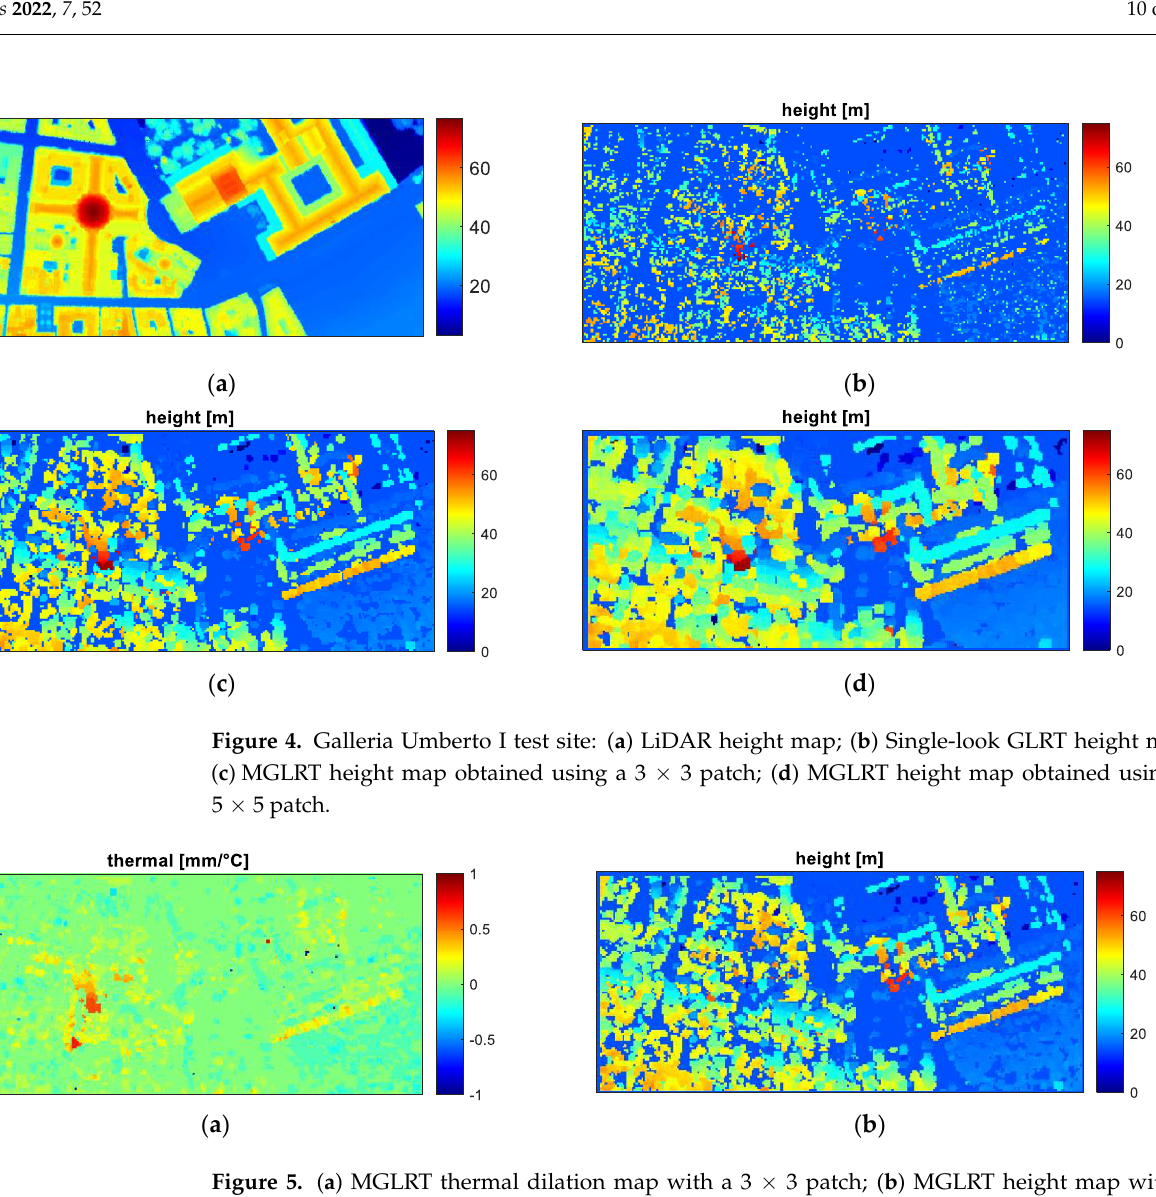
Figure 5. ( a ) MGLRT thermal dilation map with a 3 × 3 patch; ( b ) MGLRT height map with a 3 × 3 patch estimated without considering thermal dilation.